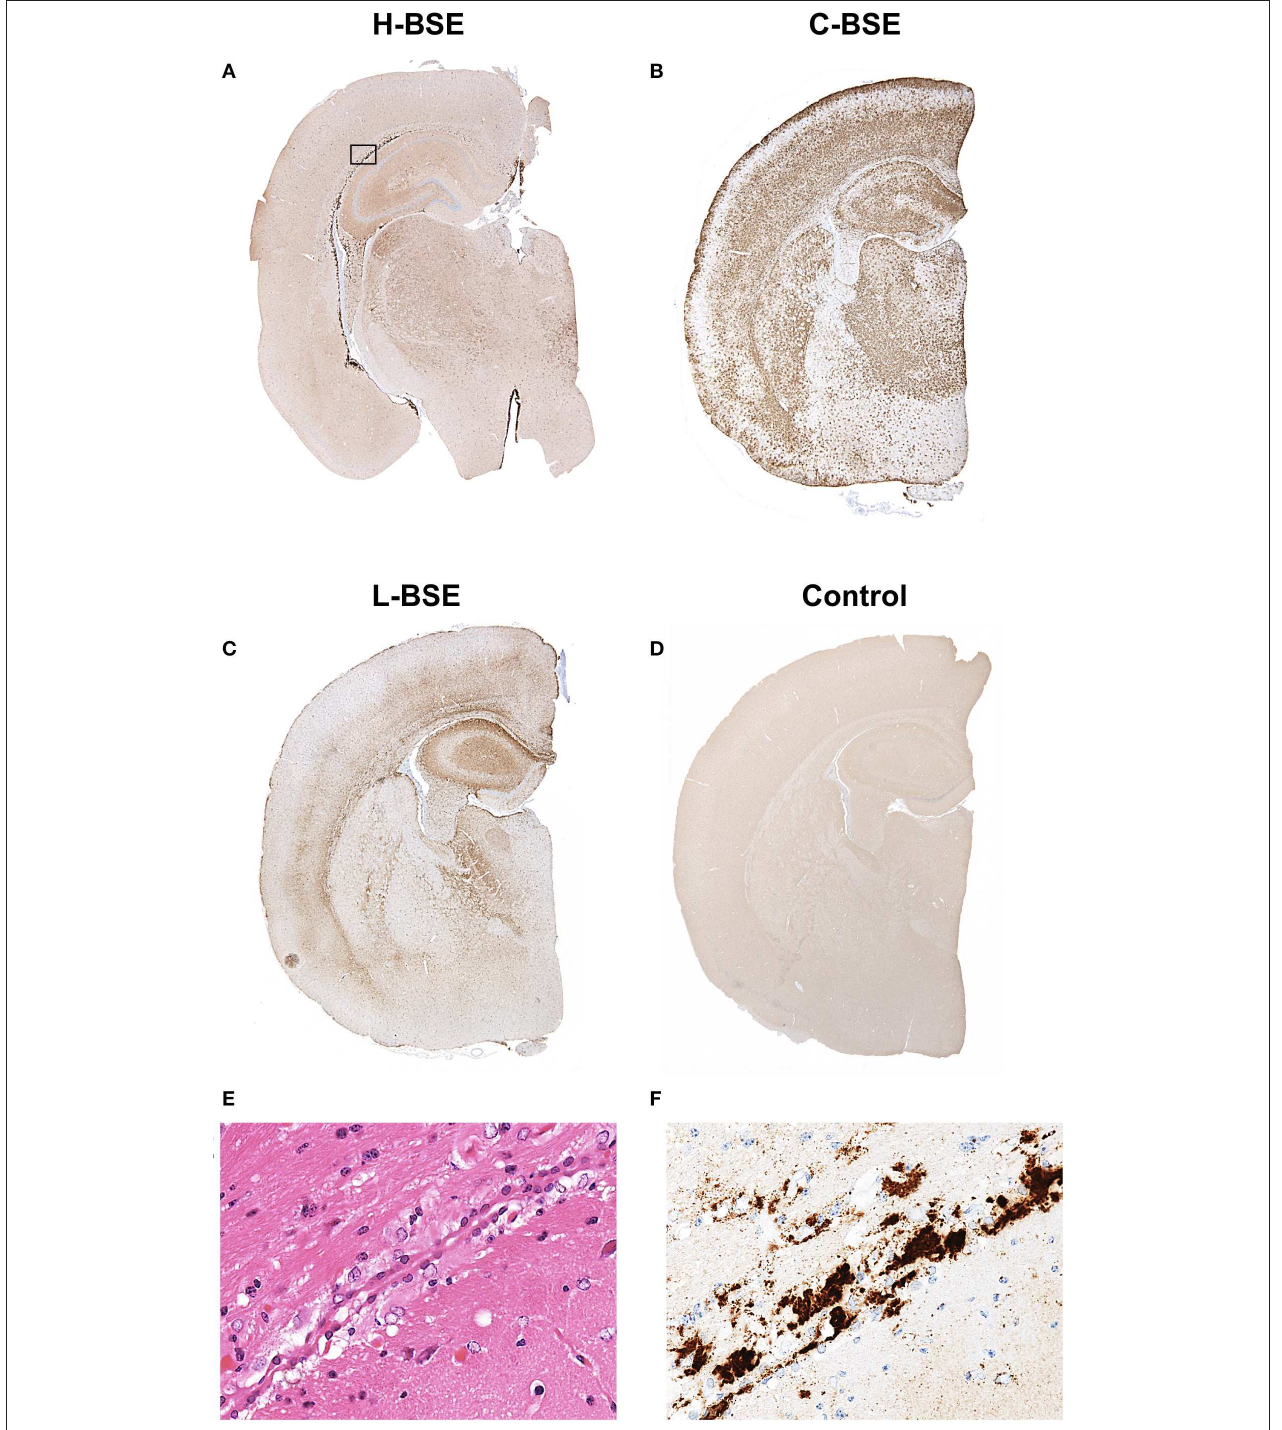
FIGURE 5 | Comparison of PrP d distribution in the brains of hamsters infected with three different BSE strains. Representative PrP d distribution in a coronal brain slice (section) at the thalamic level of a hamster infected with H-, C-, and L-BSE is shown (A–C) . A brain section from a hamster inoculated with PBS is shown as a negative control for PrP d immunohistochemistry (D) . Dense plaque-like deposits and coalescing PrP d aggregates were mainly distributed in the periventricular and subcallosal regions of the H-BSE-infected hamster, but granular PrP d was deposited throughout the brain of the C-BSE- and L-BSE-infected hamsters. The area within the box is shown enlarged (E,F) . Immunohistochemistry was performed with mAb 44B1.